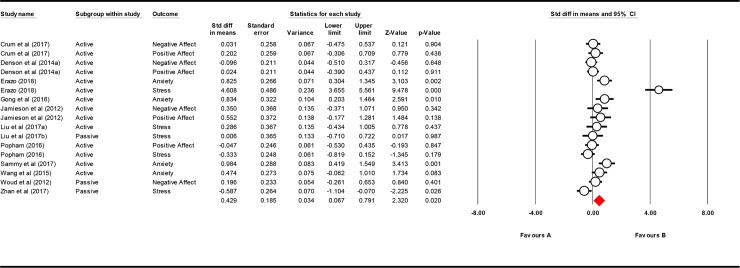
Forest plot for subjective outcomes.